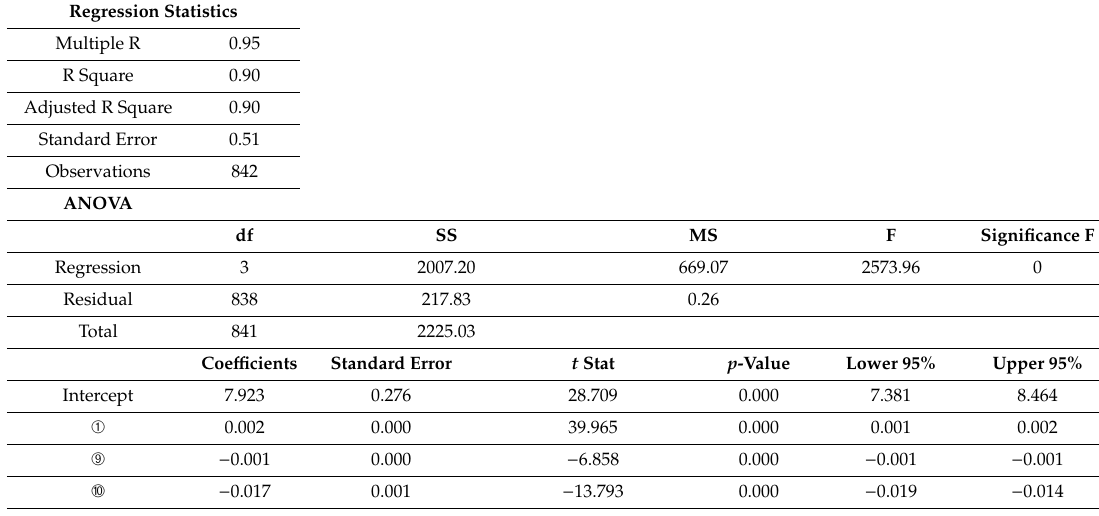
Table 7. Correlation between heating load of air-based solar heating system and climatic factors (three